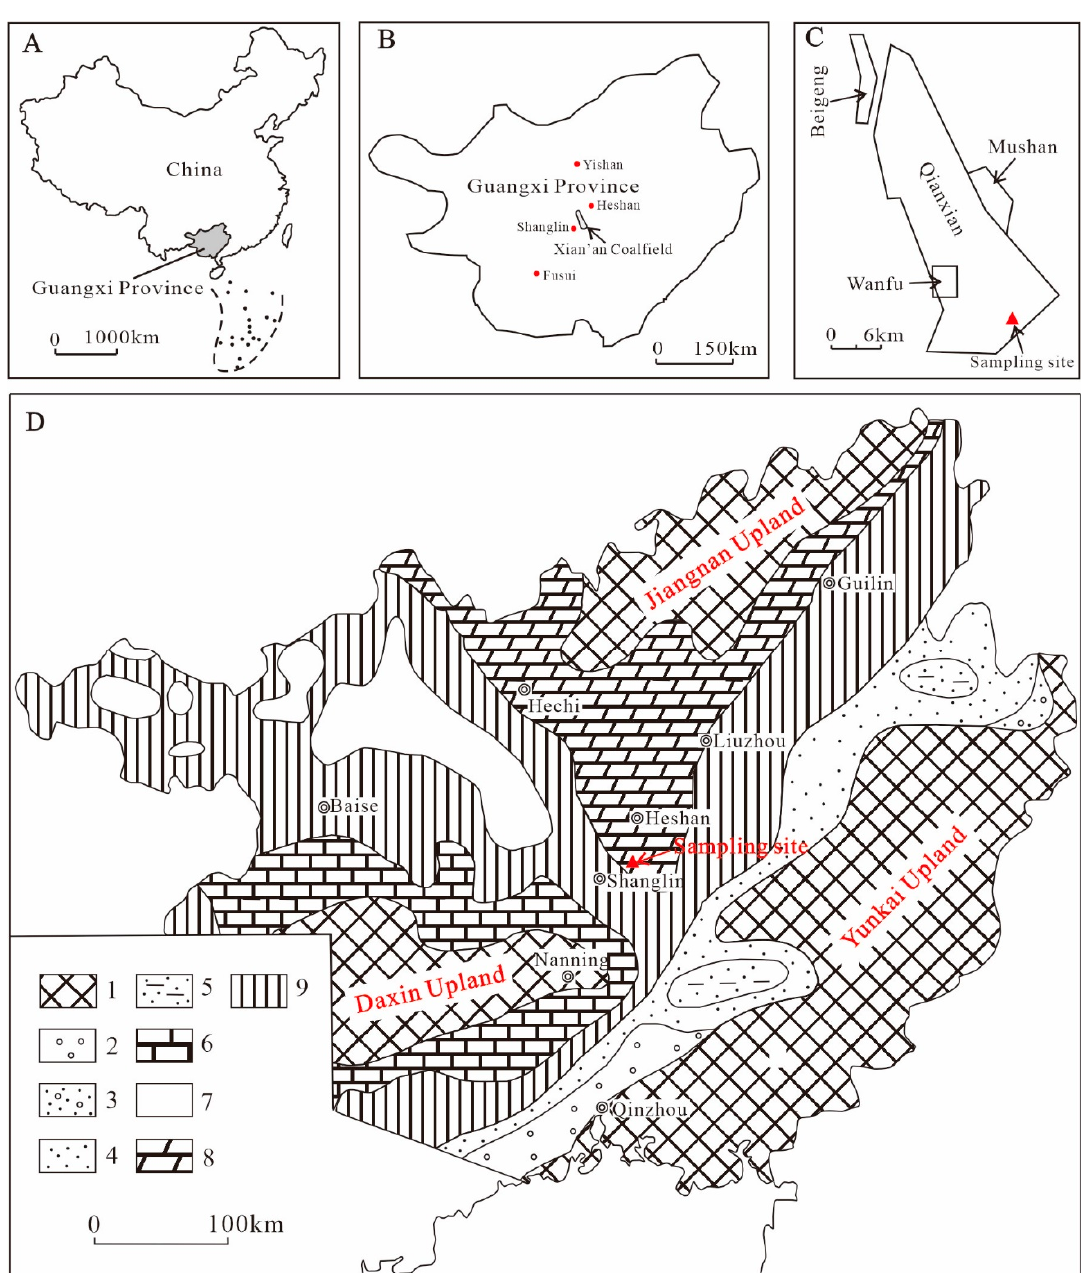
Figure 1. Maps of the study area: ( A ) Map of China showing the location of Guangxi Province, China. ( B ) Location of the Xian’an Coalfield. ( C ) Location of the coal exploration region. ( D ) Paleogeography of the late Permian period modified from [38]. 1—upland, 2—fluvial facies, 3—fluvial estuary facies, 4—clastic tidal facies, 5—lagoon, 6—lagoon-isolated carbonate platform, 7—isolated carbonate platform, 8—peat mire, 9—deep-water pyroclasts, siliceous rocks basin.